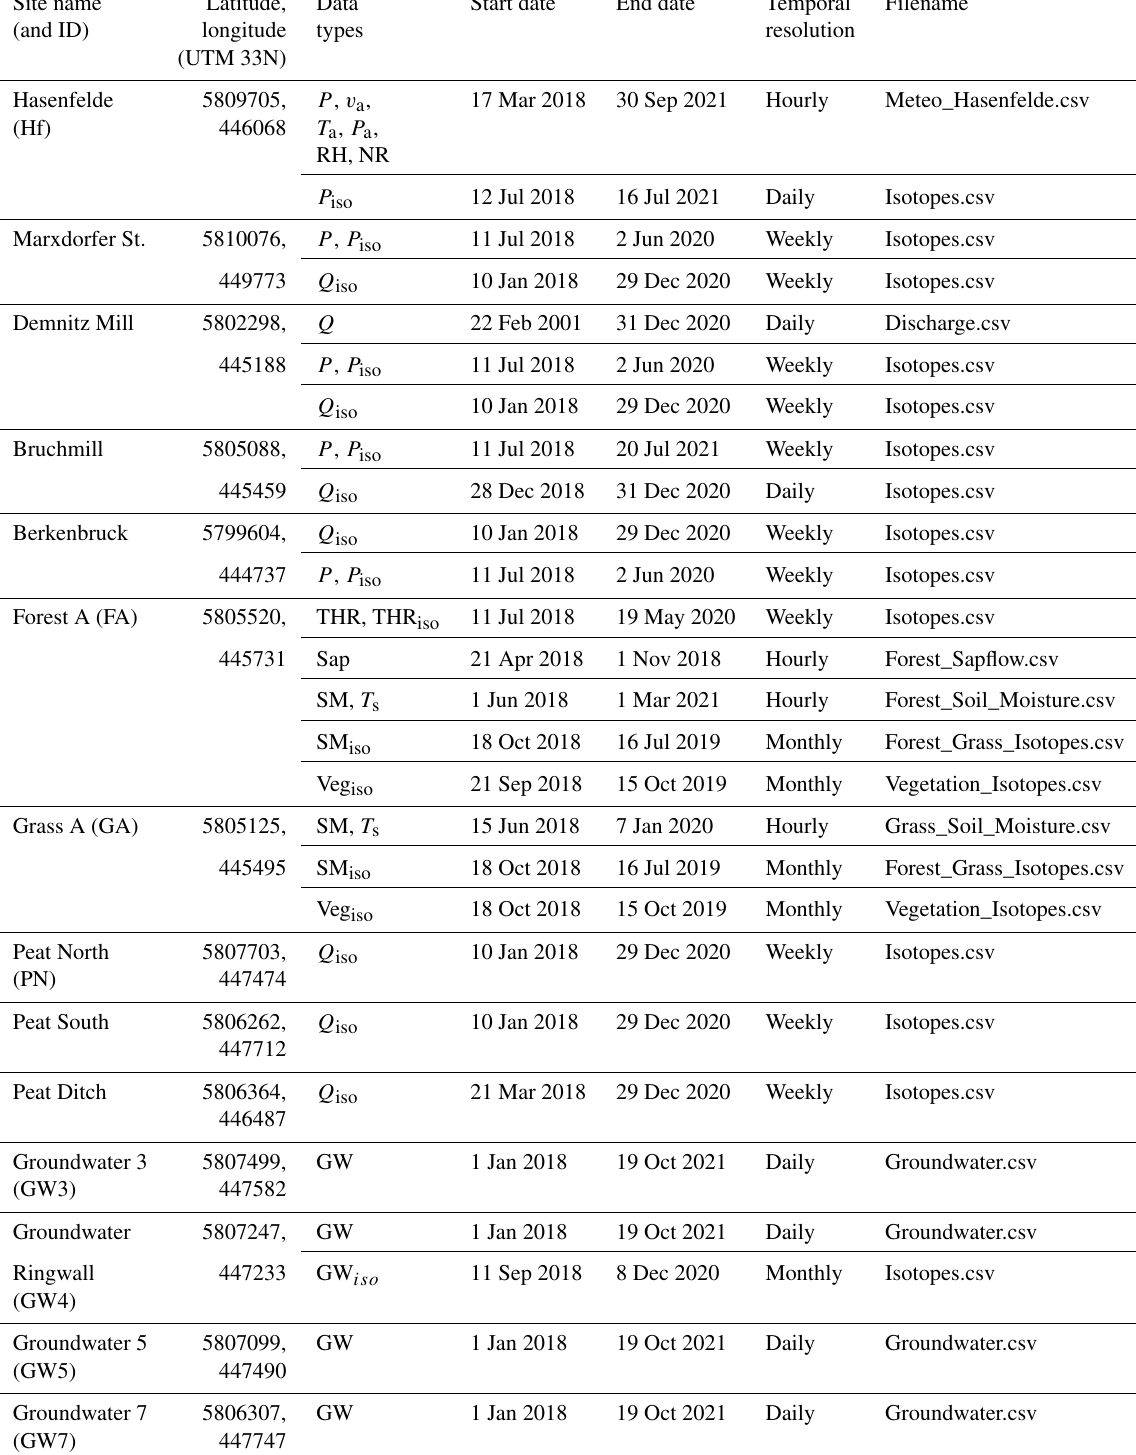
Table 2. Overview of the site locations in DMC, including the site name, coordinates, data collected, start and end dates, and resolution. P is precipitation, GW is groundwater level, THR is throughfall, T s is soil temperature, v a is wind speed/direction, T a is air temperature, P a is air pressure, RH is relative humidity, NR is net radiation, and Sap is sap flow. Veg is vegetation samples. Subscript “iso” indicates isotope